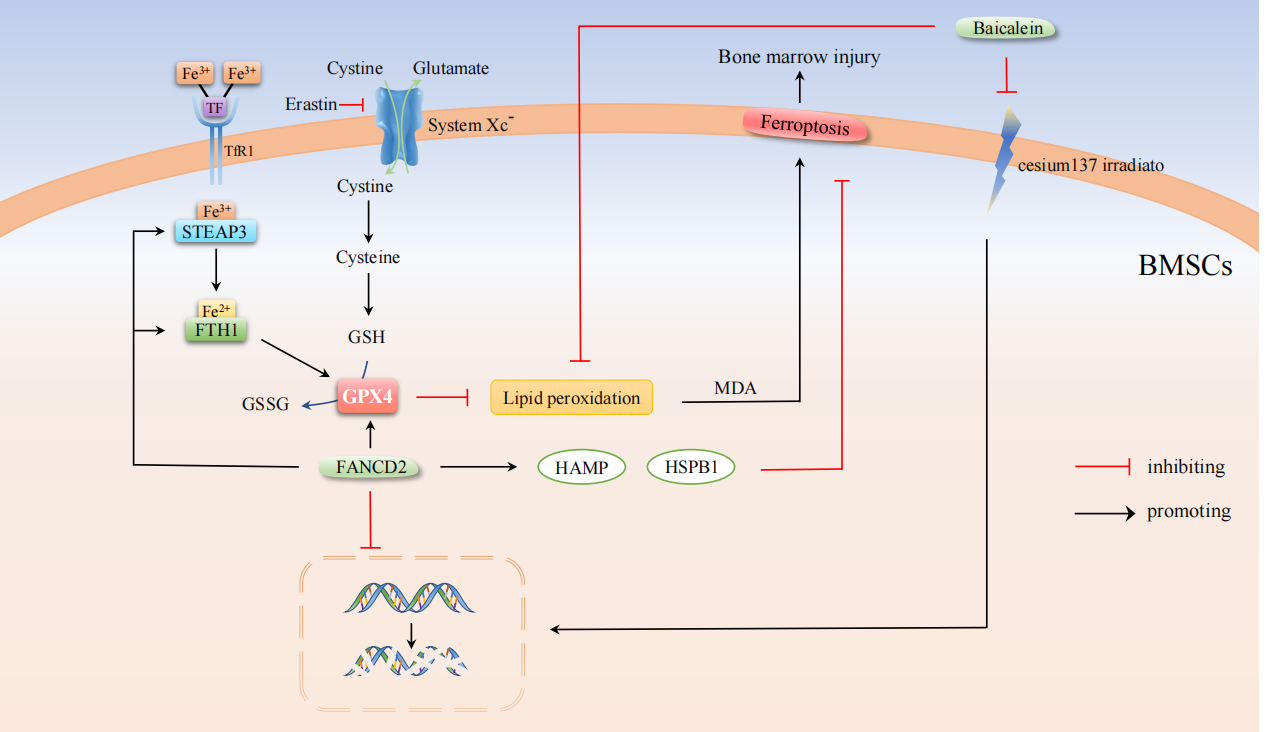
Figure 1. Molecular pathways in the regulation of bone marrow injury by ferroptosis. FANCD2 alleviated ferroptosis and reduced DNA damage by down-regulating Fe 2+ levels and up-regulating GPX4 expression. Baicalein, the ferroptosis inhibitor, alleviated FA caused by radiation-induced DNA break repair defects, thereby alleviating bone marrow injury.